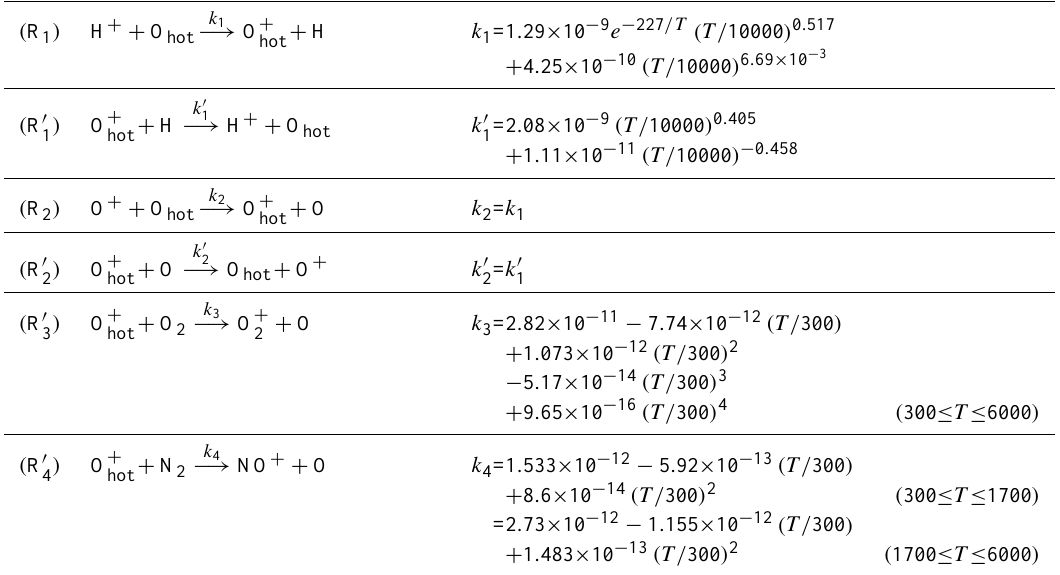
Table 1. TRANSCAR chemistry model for hot O + and the associated reactions rates. k 1 and k 0 k 4 are taken from Diloy et al. (1996). We have assumed that k 2 = k 1 since there are no available reaction rates for O + -O charge